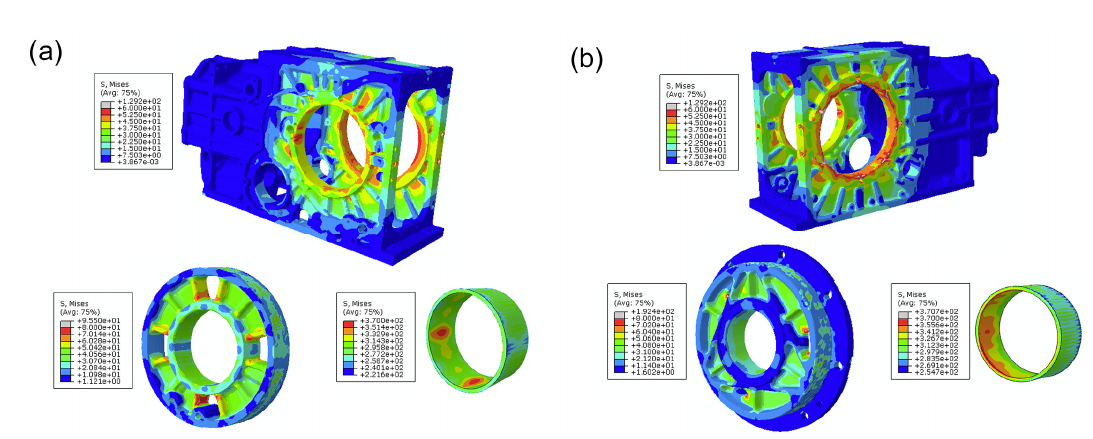
Figure 11. Von Mises stress distribution of ( a ) front bearing support system and ( b ) back bearing support system.